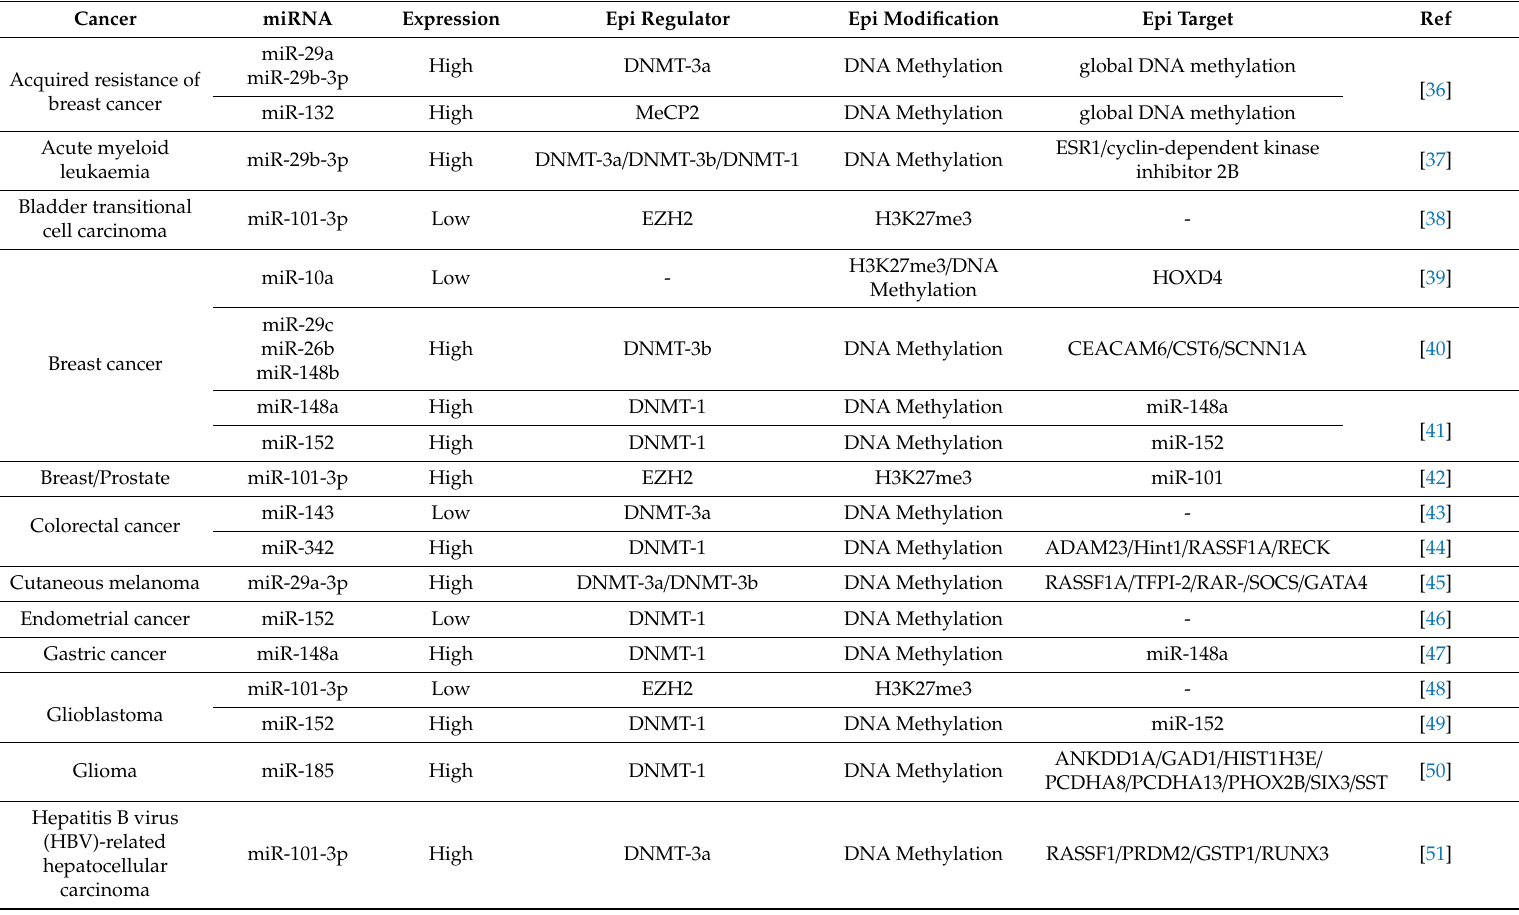
Table 1. miRNAs regulate epigenetic modifications in